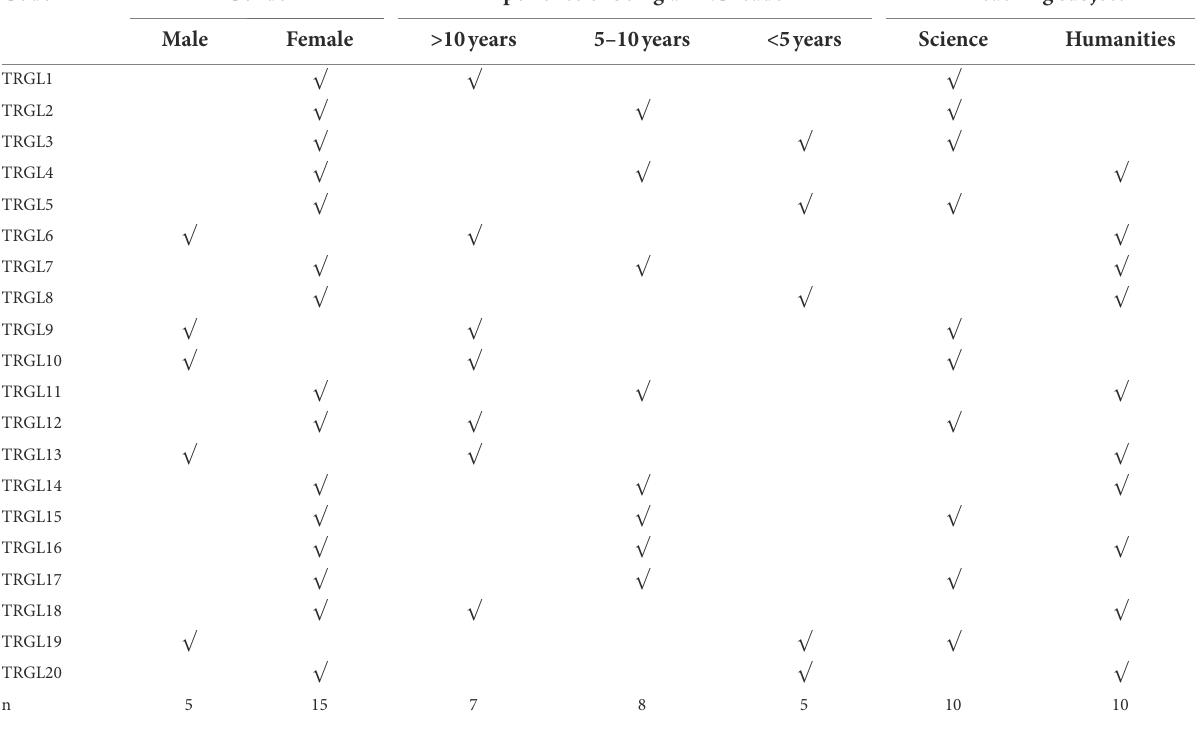
TABLE 2 TRG leaders’ demographic